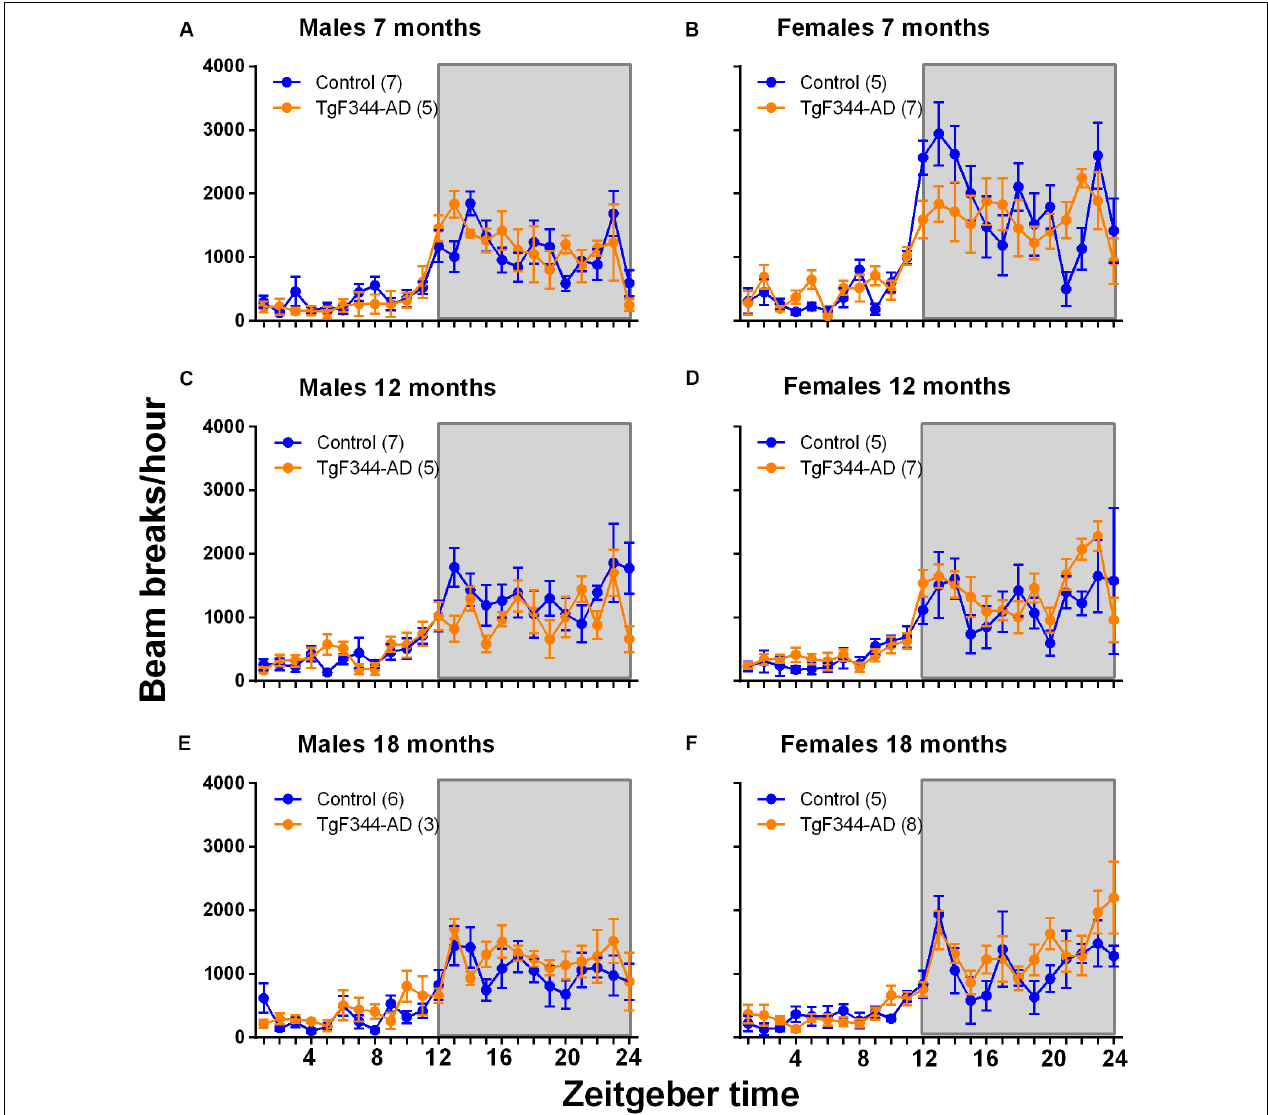
FIGURE 4 | Home cage activity in a cross-sectional study in control and TgF344-AD male (A,C,E) and female (B,D,F) rats at 7 (A,B) , 12 (C,D) , and 18 (E,F) months of age. Each point represents the mean ± SEM for the number of rats indicated in parentheses. The abscissa represents 1-h epochs across time with epoch 1 representing 6 am–7 am; lights were on at 6 am and lights were off at 6 pm, as indicated by the shaded area. In males, only the main effect of epoch was statistically significant, indicating regardless of age or genotype, activity varies with epoch. In females, the age × epoch interaction was statistically significant indicating that regardless of genotype, younger rats were more active compared with the 12- and 18-month old animals; effects were statistically significant at 8th, 11th, 12th, and 20th epochs. Younger rats were more active than 18-month old rats at the 18th